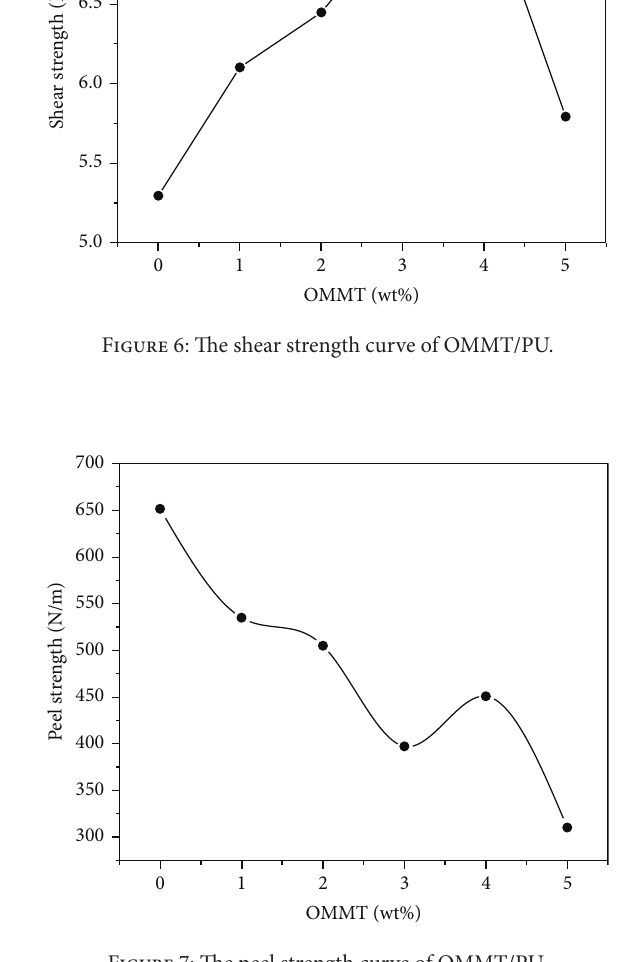
Figure 7: The peel strength curve of